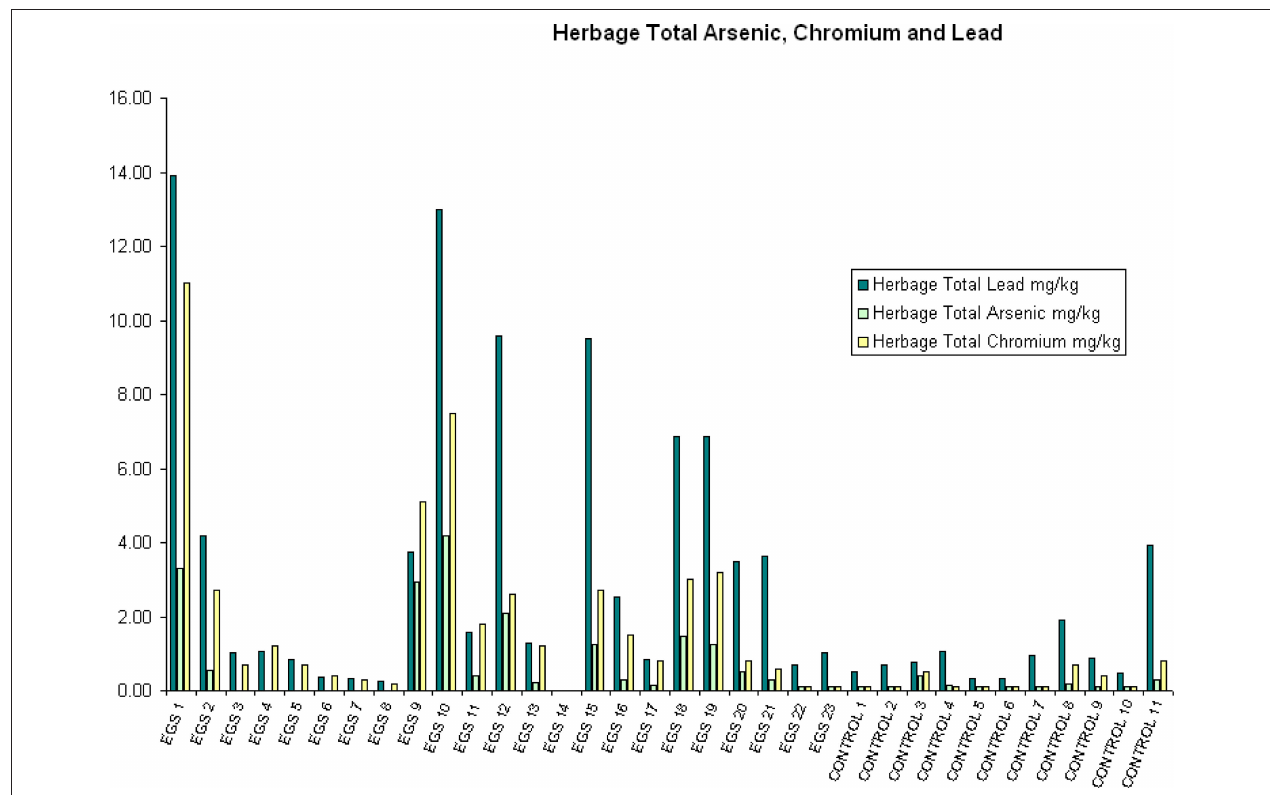
FIGURE 3 | Herbage total arsenic, chromium, and lead. Herbage total arsenic, chromium, and lead (mg/kg) per site (EGS and controls).